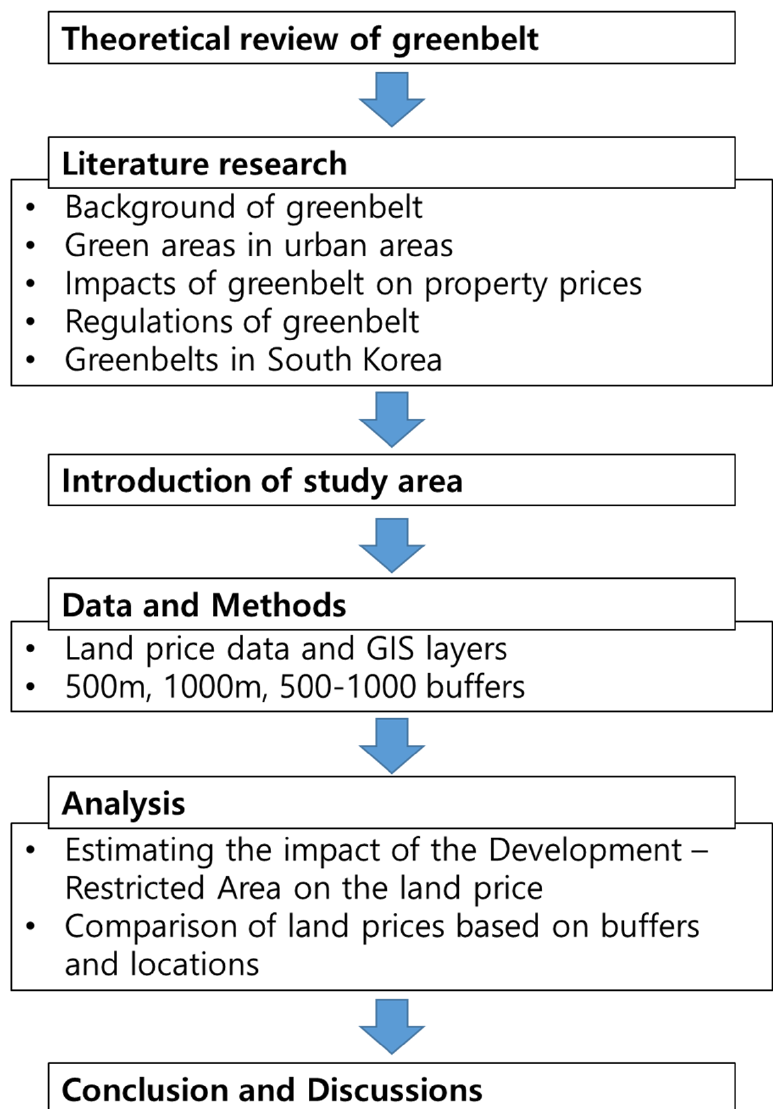
Figure 1. Flowchart of the stages of this study’s research. Greenbelts in South Korea